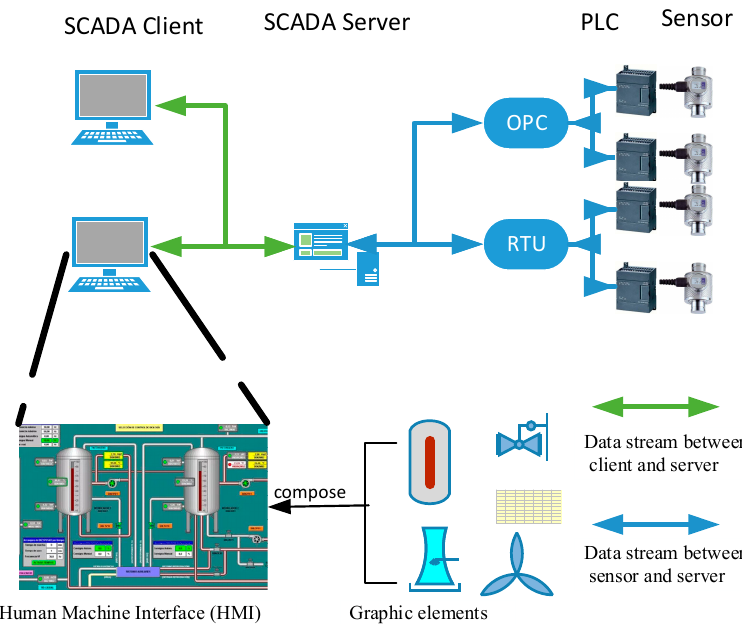
Figure 1. Procedure of real-time sensor data acquisition and visualization in supervisory control and data acquisition (SCADA).